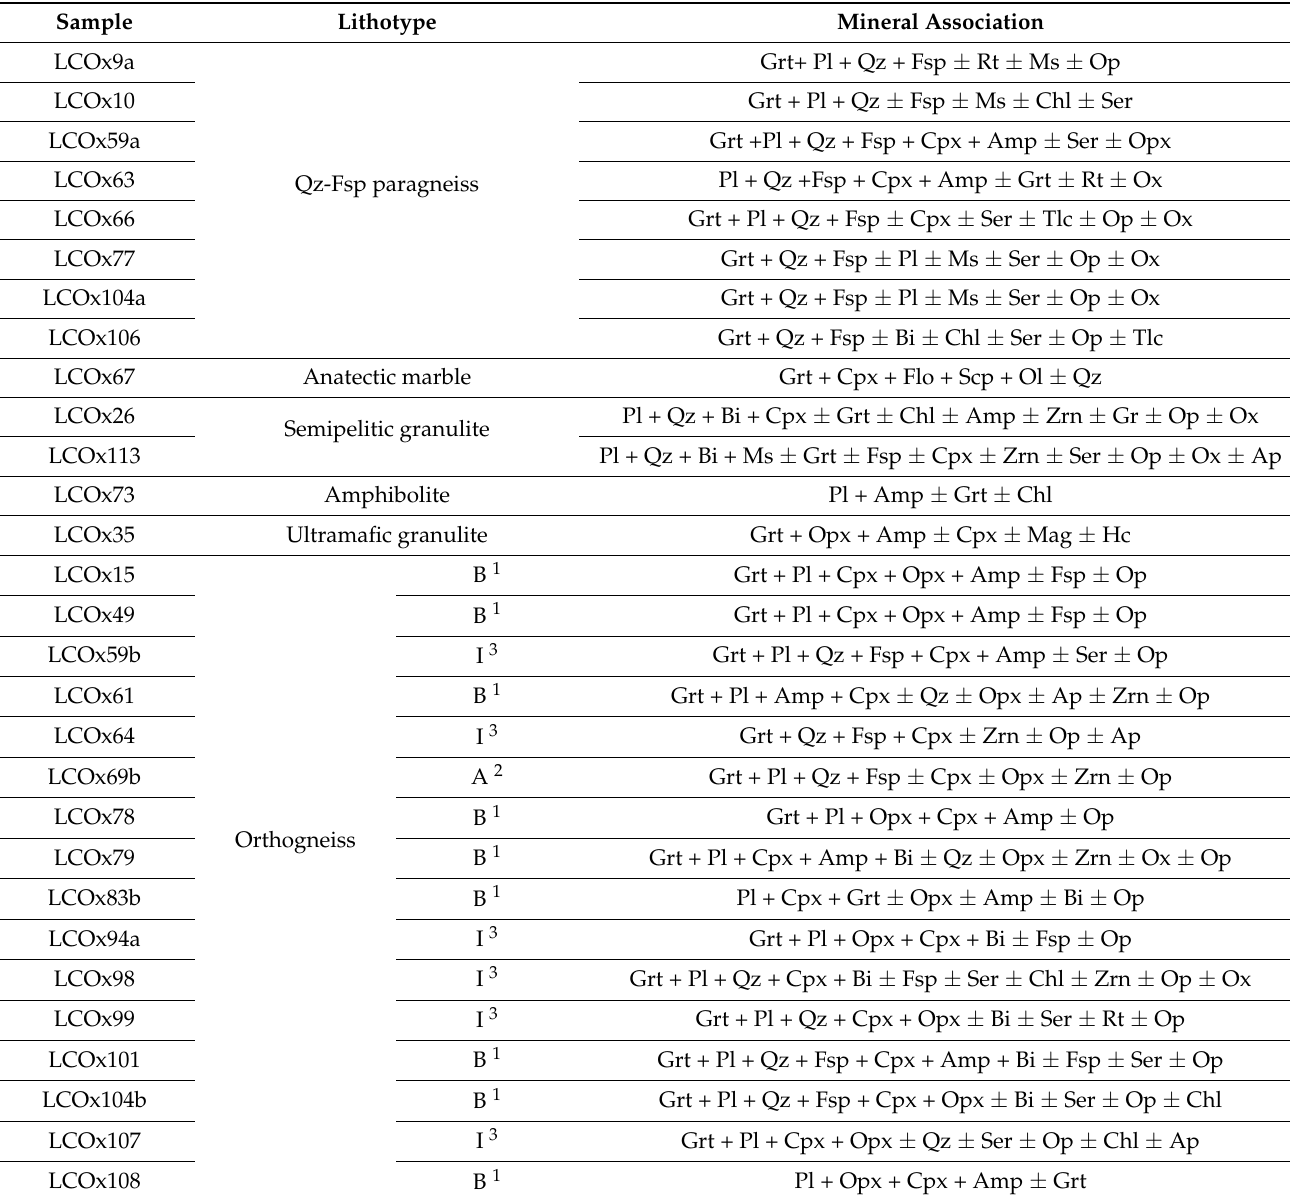
Table 1. Collected samples with their lithotype and mineral association. LCOx26 sample is located outside the study site, northwest of the Ejutla de Crespo (Figure 2). Mineral abbreviations according to [26]; Op: opaque and Ox: